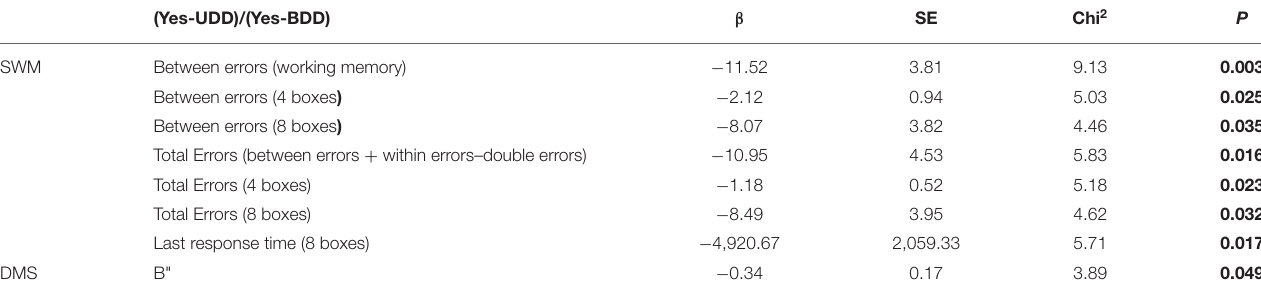
TABLE 3 | Results of GEE analysis regarding the effects of depression types and response to treatment on CANTAB scores (UDD responders vs. UDD Non-responders). (Yes-UDD)/(No-UDD) β SE Chi 2 P SWM Between errors (4 boxes ) − 2.25 Between errors (6 boxes )